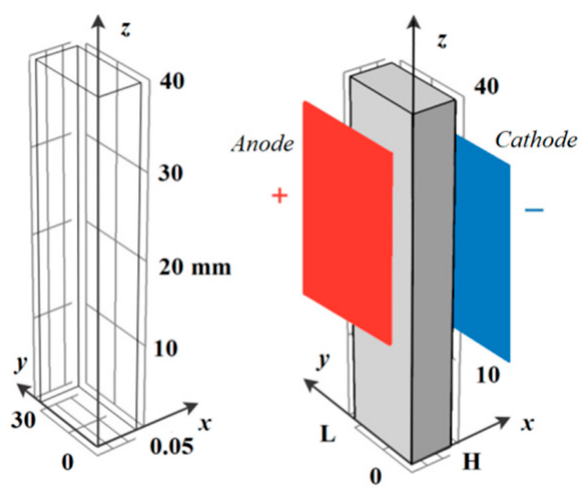
Figure 7. Scheme of a 3D cell with a magnetic fluid (electrodes are highlighted in color) with research areas in the form of a rectangular parallelepiped.